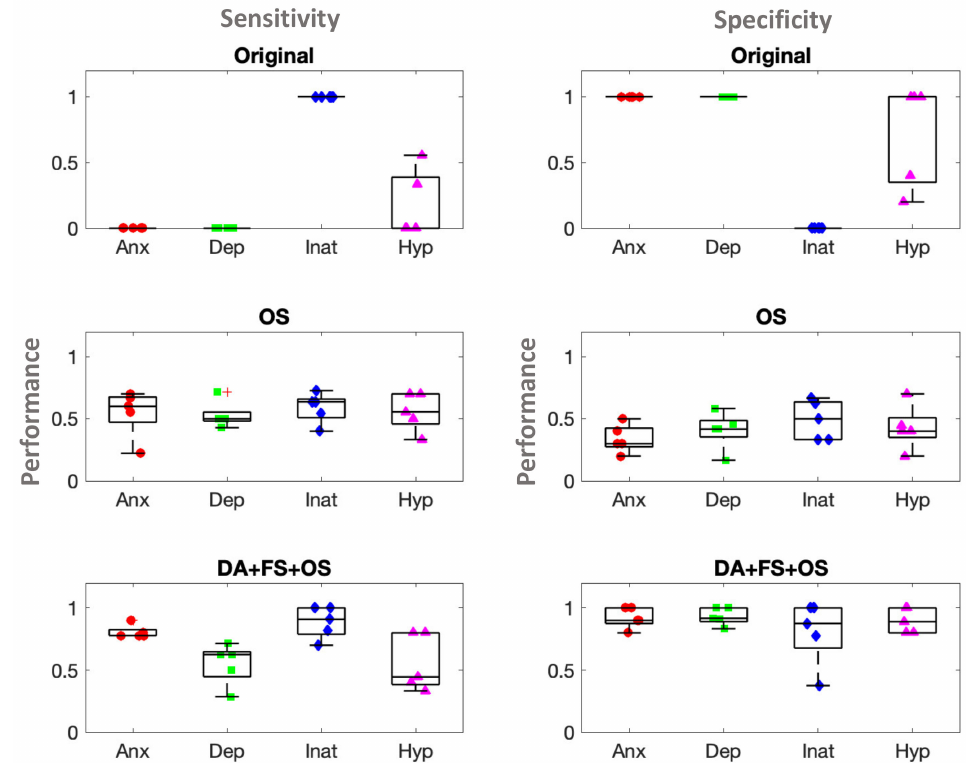
Figure 4. Comparison of performance of logistic regression with and without modification of the original dataset. Bar plots show comparison of prediction performance, sensitivity ( left column ), and specificity ( right column ) of 4 mental health symptoms (i) anxiety, (ii) depression, (iii) inattention, and (iv) hyperactivity, by logistic regression applied to different datasets.Original: original dataset ( first row ); OS: over-sampled (SMOTE and adding Gaussian noise) dataset ( second row ); DA + FS + OS: dataset that underwent all three processes ( third row ), data augmentation (increase of feature), feature selection (reduction of feature) based on chi-square statistic, and oversampling (SMOTE and adding Gaussian